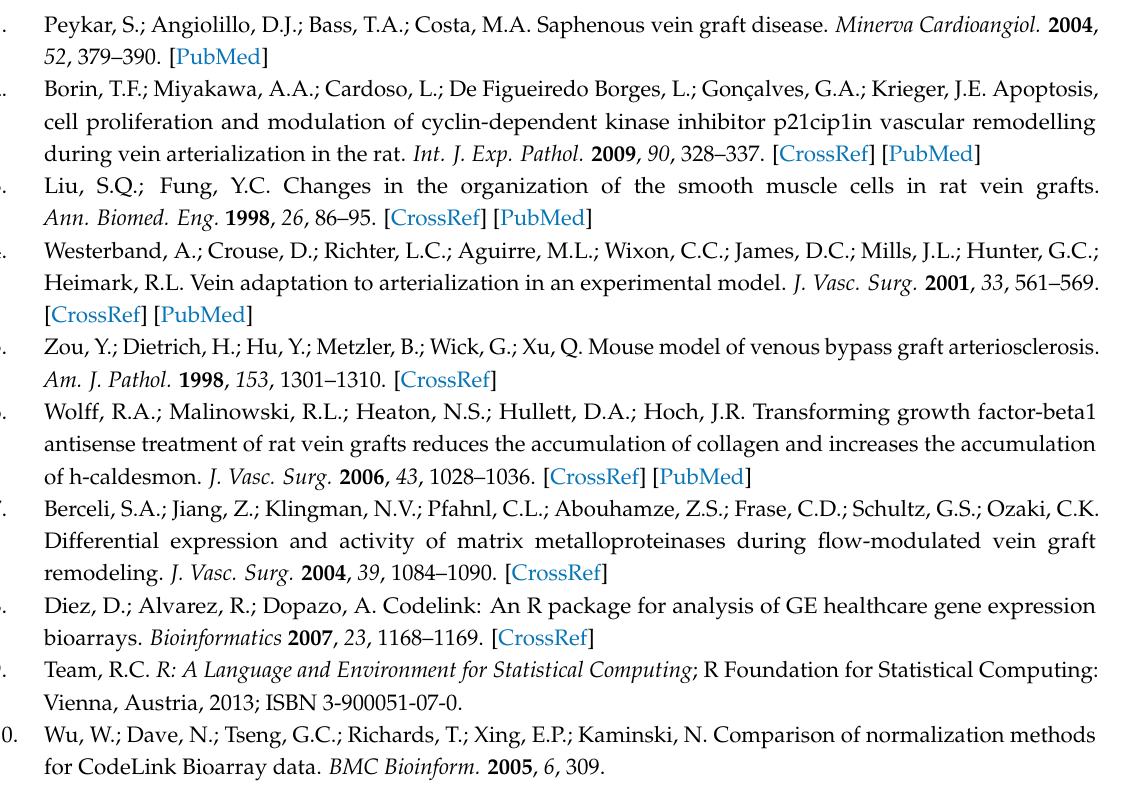
Figure S1. Data quality evaluation. Representative MA plot depicting log-intensity overall expression average data versus log-intensity ratios (A) before and after (B) background correction and cyclic loess normalization. (C) Normalized signal box-plots indicating the lack of significant differences in the log-intensity expression average among every group. Table S1: Disease and function analysis using IPA knowledgebase for 3 days of venous arterialization compared with normal jugular vein. Table S2: Disease and function analysis using IPA knowledgebase for 28 days of venous arterialization compared with normal jugular vein. Table S3: The top 10 genes upregulated and downregulated after 3 days of venous arterialization compared with normal jugular vein. Table S4: The top 10 genes upregulated and downregulated after 28 days of venous arterialization compared with normal jugular vein. All-comaparisons.xlsx: Excel file containing the genes differentially expressed between J × C, J × 3D, J × 28D, C × 3D, C × 28D and 3D and 28D. Each spreadsheet tab has the information of Genebank ID, Codelink ID, fold change, p -value and FDR corrected p -value for each